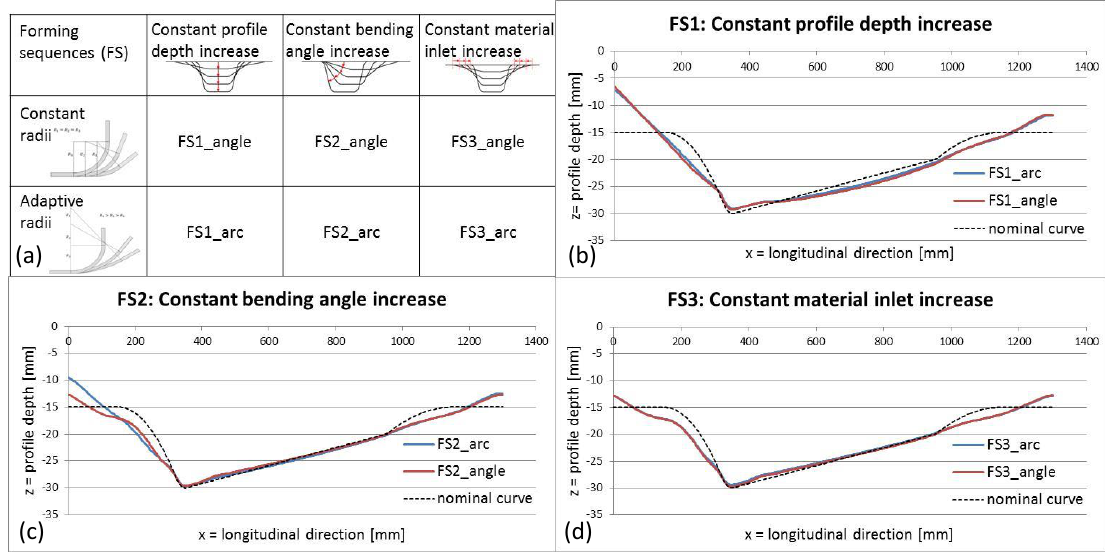
Figure 17. Forming strategies and the resulting profile bottom contours.